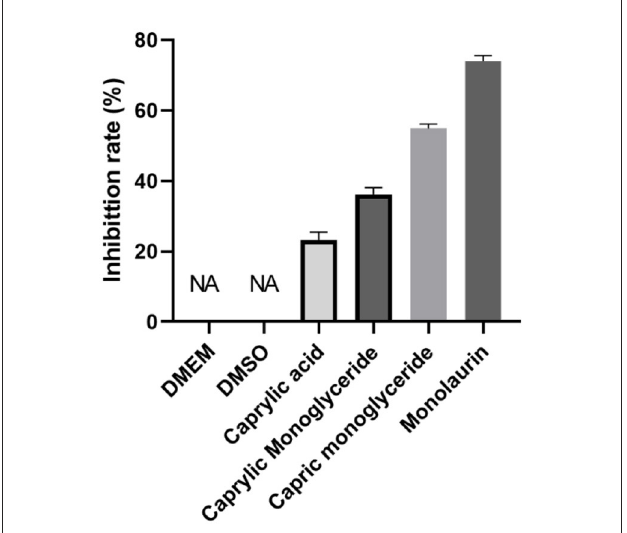
FIGURE2 In vitro evaluation of the anti-SVV activity of MCFAs.